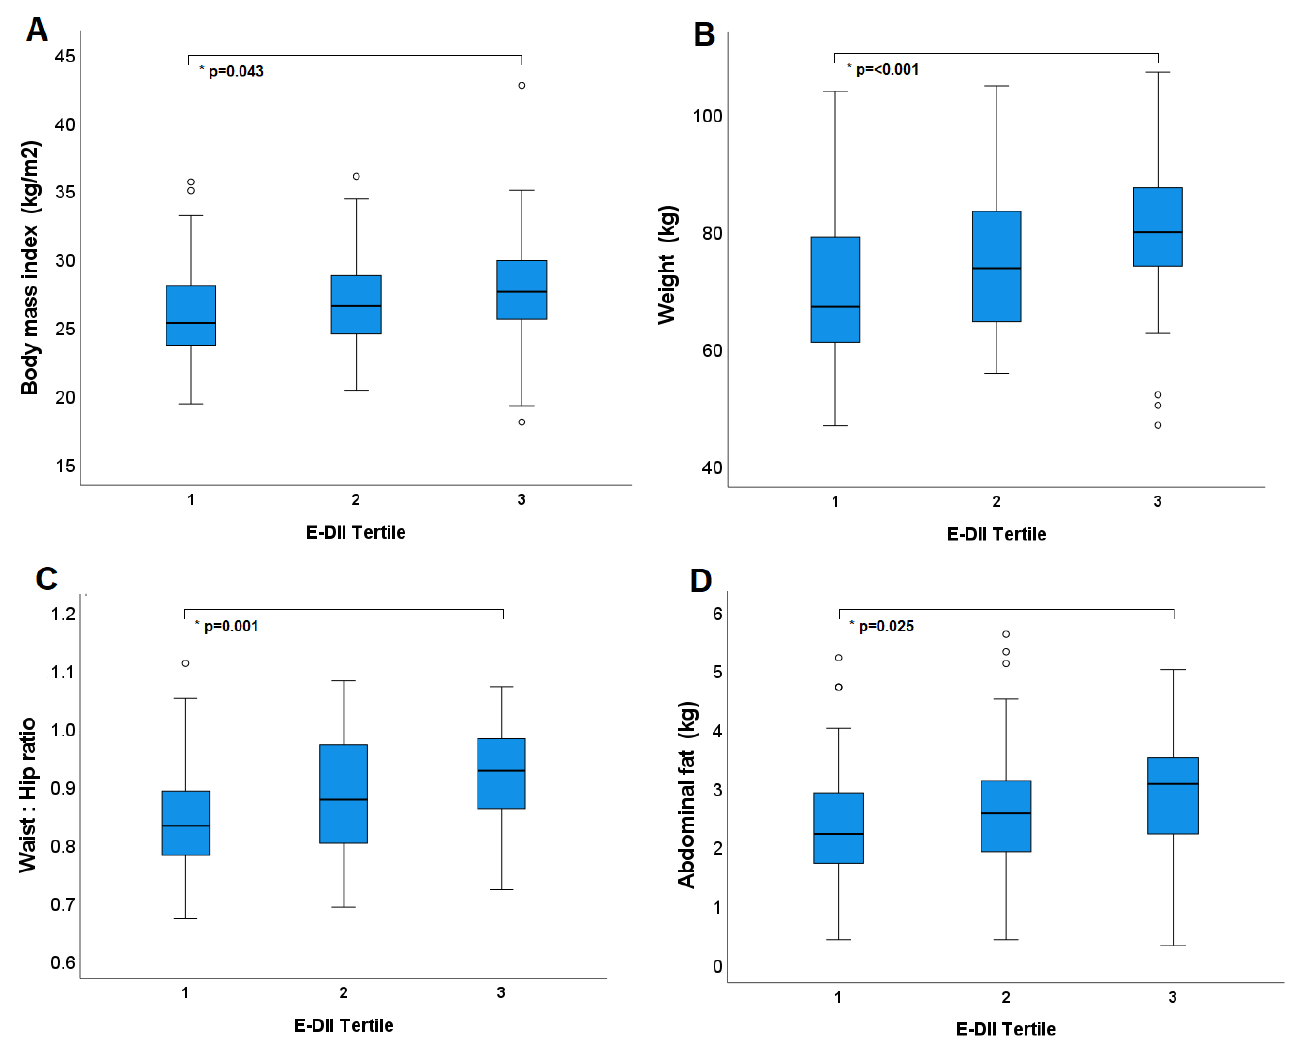
Figure 3. Tertiles of dietary inflammatory index (adjusted for energy) and adiposity at baseline: ( A ) body mass index; ( B ) weight in kilograms; ( C ) waist to hip ratio; ( D ) abdominal fat as determined by DEXA scan. * p values represent statistical significance determine by LMEM. Circles outside error bars represent outliers.